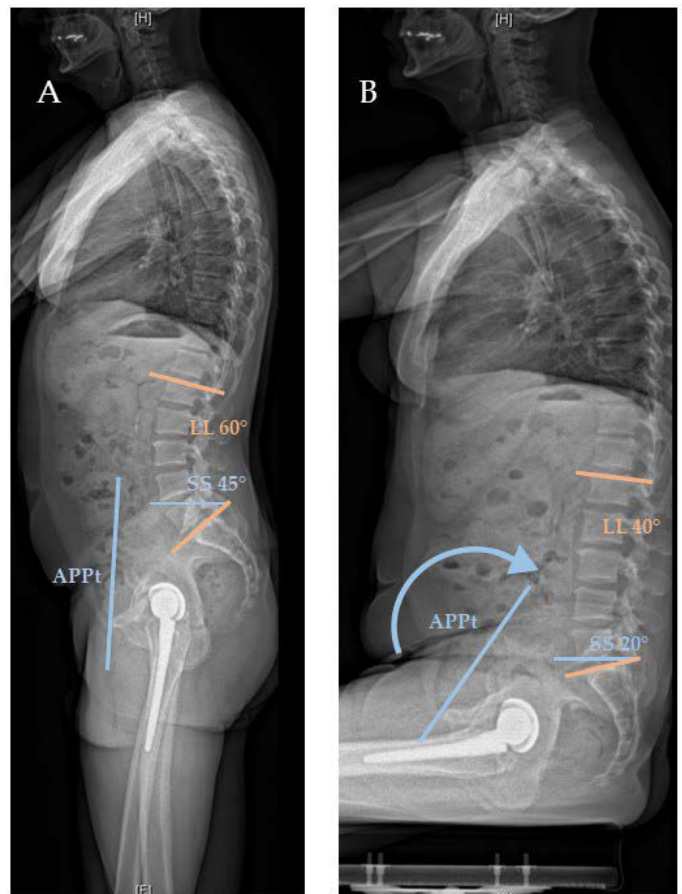
Figure 1. Normal spinopelvic motion with an increase in posterior pelvic tilt (APPt) (blue arrow) and decrease of sacral slope (SS) (blue and orange) and lumbar lordosis (LL) (orange) in lateral standing ( A ) and sitting ( B ) EOS radiographs.